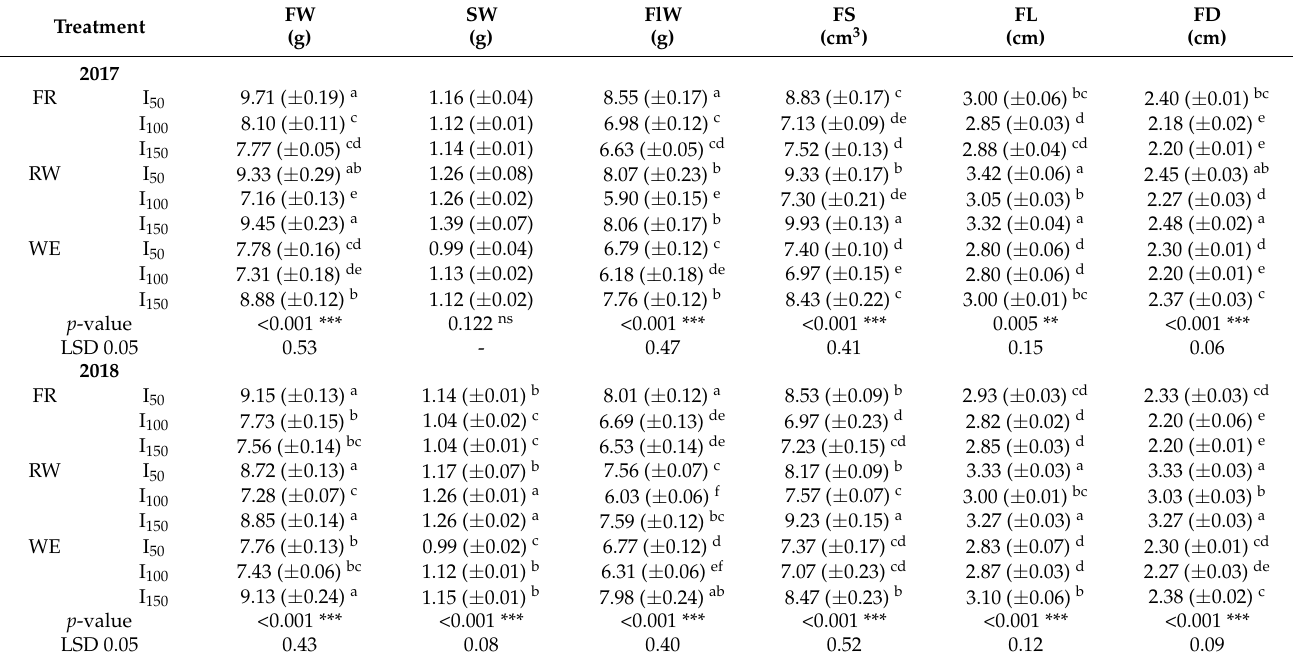
Table 5. Comparison of physical characteristics of dates across the experimental treatments from 2017 to 2018. Treatment